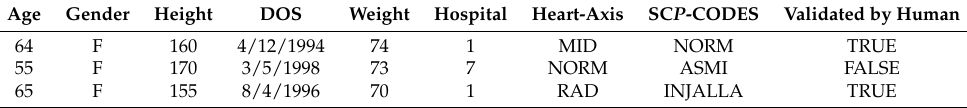
Table 7. Females’ data